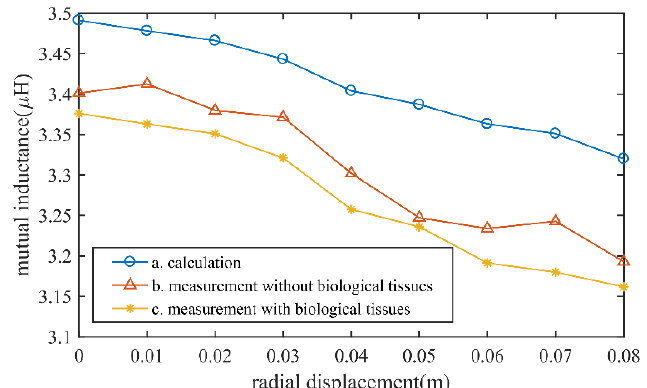
Figure 10. Mutual inductance from calculation of proposed model, measurement with biological tissues, and measurement without tissues.